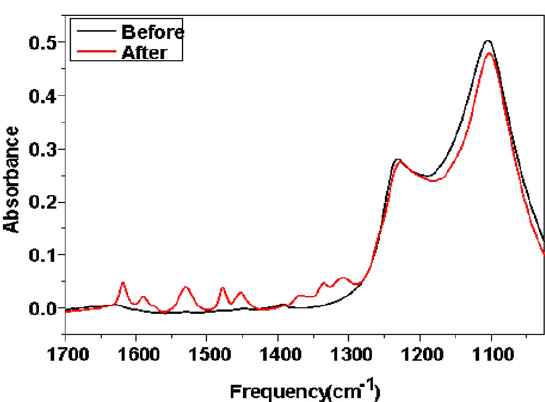
Figure 7. Infrared spectra of the HBEA zeolite before and after ad- sorption of